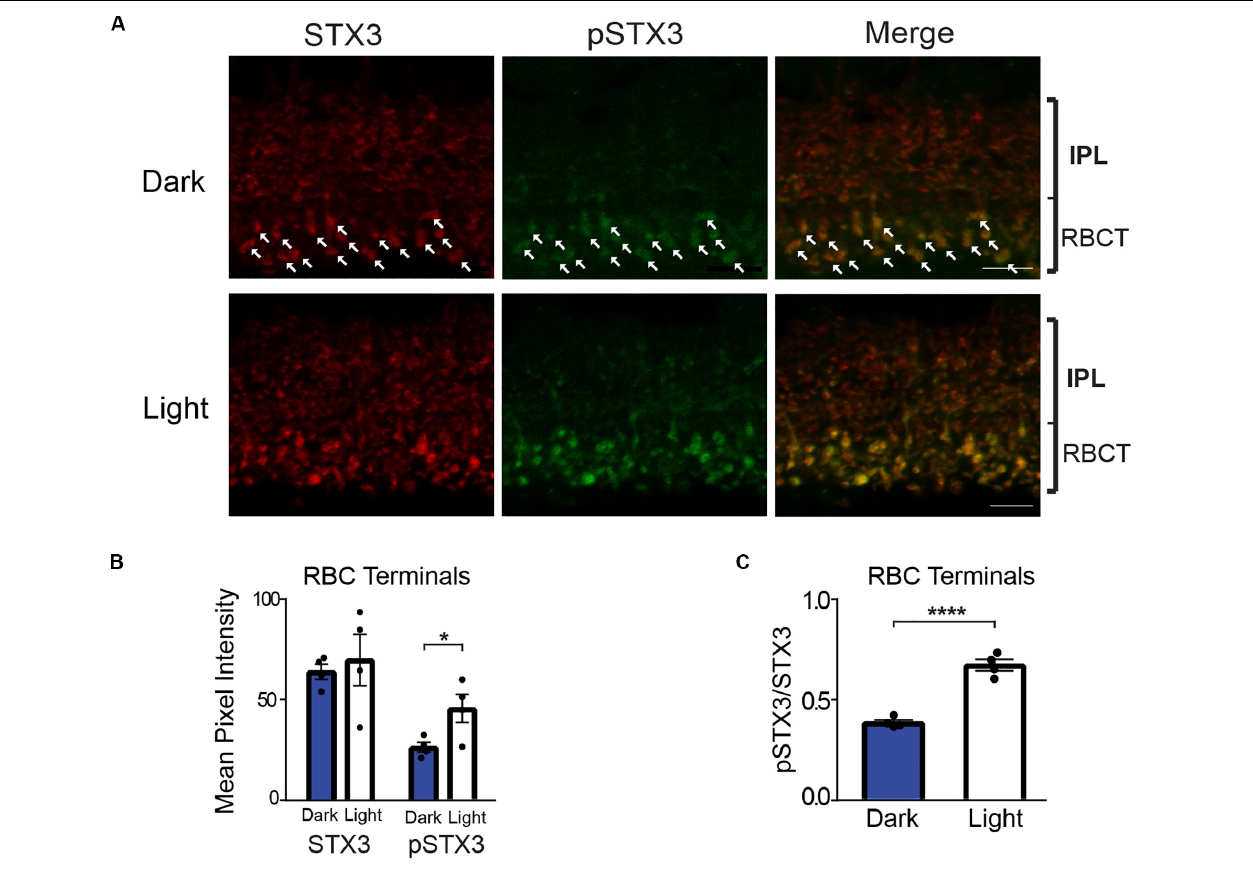
FIGURE 2 | In rod bipolar cell terminals, phosphorylation of STX3 at T14 is greater in light-exposed mice than dark-adapted mice. (A) Top: A representative set of confocal images of a vertical section through the inner plexiform layer (IPL) of a dark-adapted mouse retina. Arrows mark some of the rod bipolar cell synaptic terminals. Bottom: A representative set of confocal images through the IPL of a retina from a dark-adapted mouse exposed to a 15-min light stimulus. Note the obvious double-labeling for pSTX3 and pSTX3 in rod bipolar cell terminals. For all, retinal sections were doubled-labeled for STX3 (red), and pSTX3 (green). The small bracket labeled “RBCT” indicates the region of the IPL where the rod bipolar cell terminals (RBCT) reside. Scale bar = 10 µ m. (B) Quantification of the rod bipolar cell terminal mean pixel intensities demonstrates that only the mean intensity of pSTX3 immunolabeling is light-sensitive p = (0.0415). Quantification of the pSTX3 to STX3 ratio in rod bipolar cells terminals demonstrates that in the light-treated mouse (white bars) the ratio of pSTX3 to STX3 is significantly greater in the dark-adapted mouse (blue bars). p < 0.0001. For (B,C) , n = 4,4 (mice). *Indicates p < 0.05 and ****indicates p <